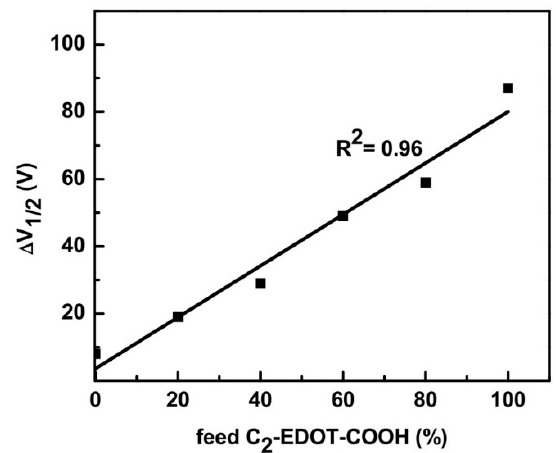
Figure 5. Di ff erences of onset potential in bu ff er solution at pH 4 and pH 10 from Figure 5. Differences of onset potential in buffer solution at pH 4 and pH 10 from poly(EDOT-OH- co - poly(EDOT-OH- co -C 2 -EDOT-COOH) with di ff erent feed C 2 -EDOT-COOH C 2 -EDOT-COOH) with different feed C 2 -EDOT-COOH composition.